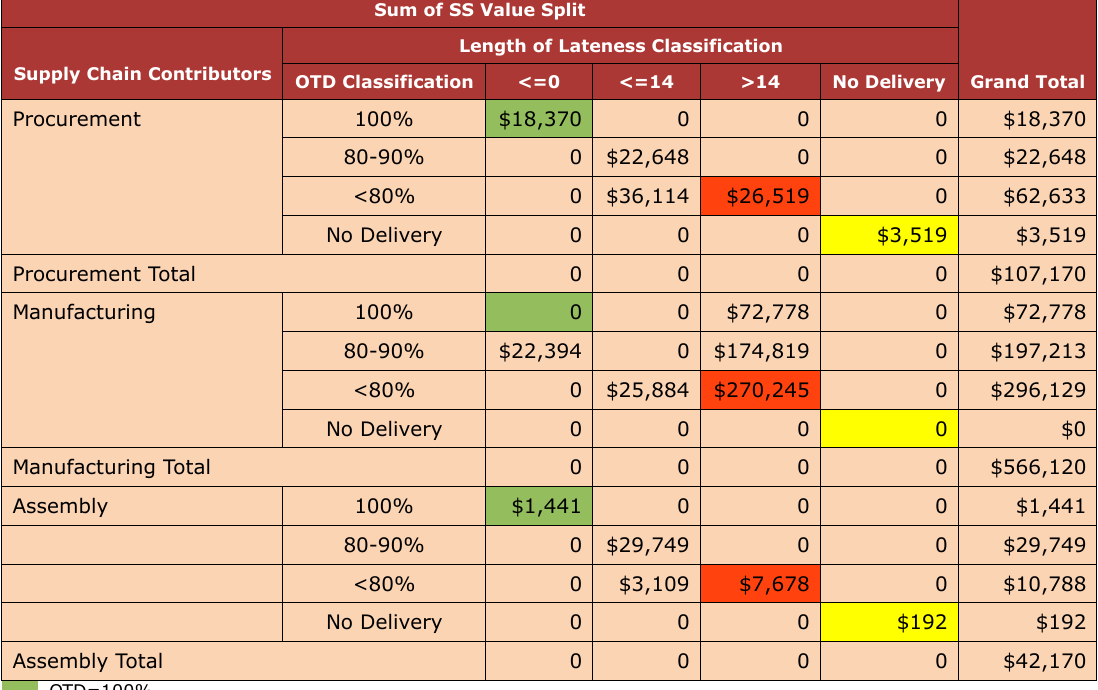
Table 6. OTD and Length of Lateness